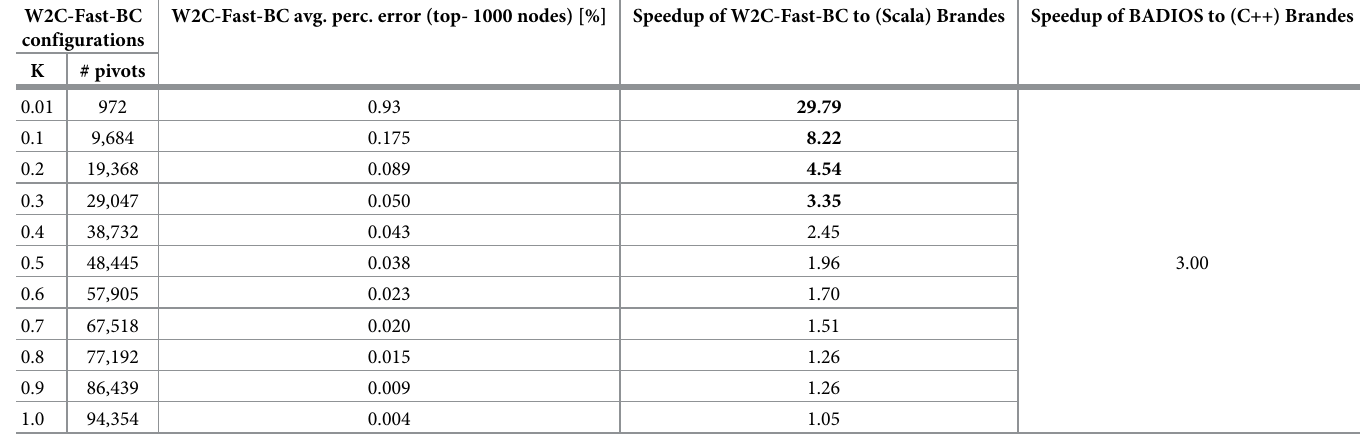
Table 2. Performance evaluation in sequential settings: Comparison of W2C-Fast-BC with respect to Brandes [15] and of BADIOS [42, 43] to Brandes. W2C-Fast-BC